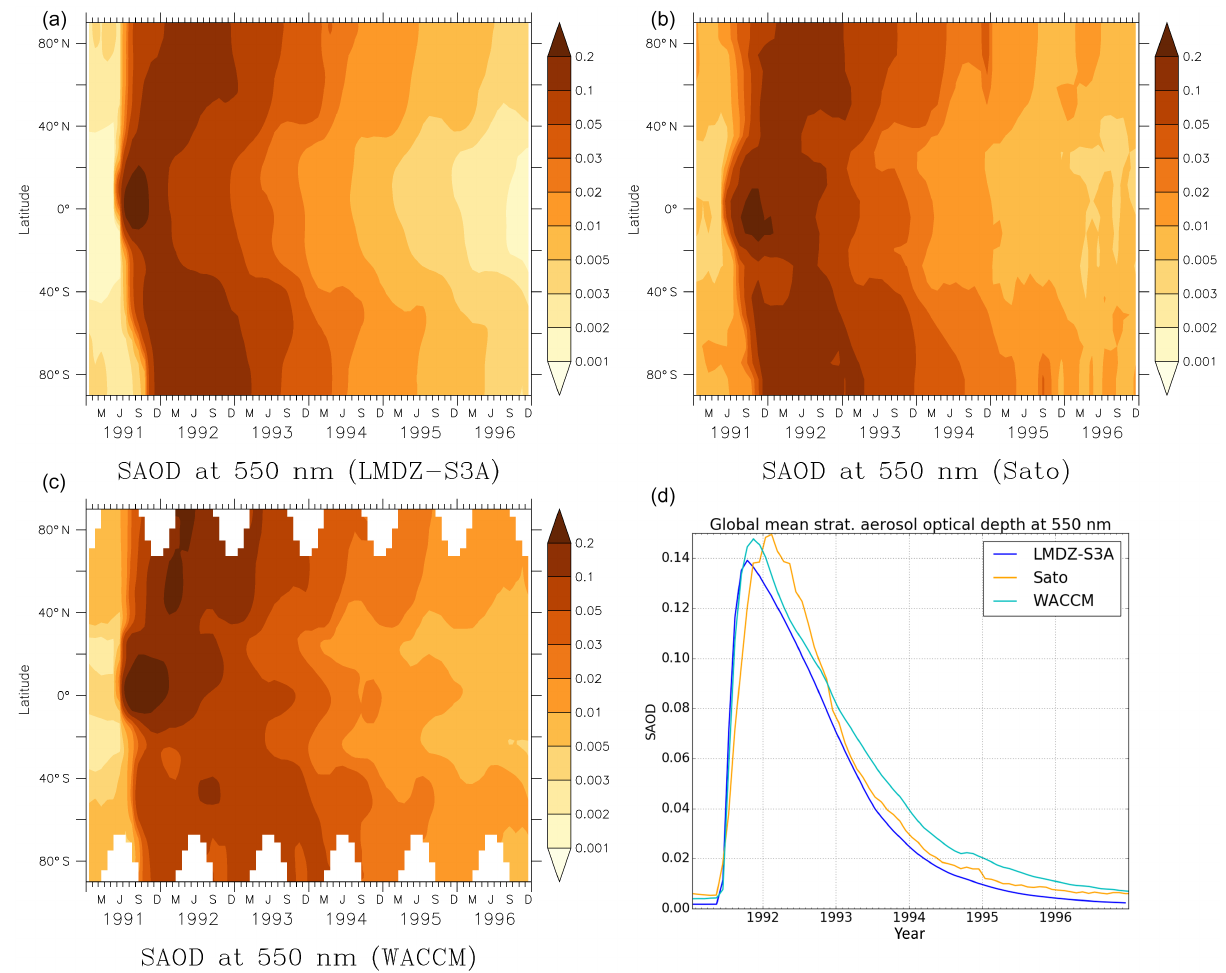
Figure 8. Evolution of the zonal mean stratospheric aerosol optical depth (SAOD) at 550nm modelled with LMDZ-S3A (a) compared to the climatology from Sato (2012) (b) and to SAOD simulated with WACCM by Mills et al. (2016) (c) , as well as the global mean SAOD (d) . Note that, unlike our simulation, WACCM includes small volcanic eruptions that occurred after that of Mount